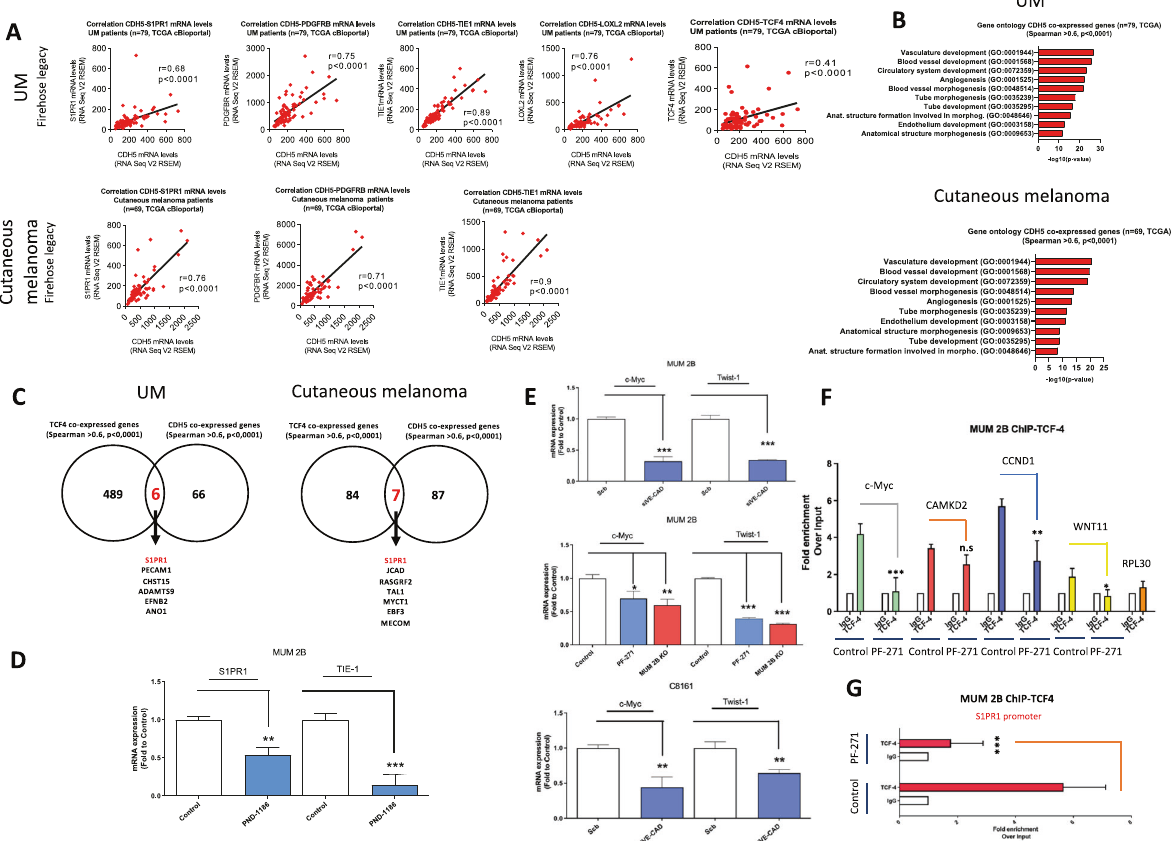
Fig. 4 VE-Cadherin/ β -catenin forms a complex in FAK-dependent manner enhance TCF-4 transcription activity. A Evaluation of the correlation between CDH5 and S1PR1, PDGFRB, TIE1, LOXL2, and TCF4 mRNA levels in a cohort of uveal melanoma ( n = 79, TCGA Firehose legacy) and cutaneous melanoma patients ( n = 69, TCGA, Firehose legacy) using cBioPortal. Correlation analysis was done using the Spearman test. B Top 10 gene ontology terms of CDH5 positive correlated genes ( r > 0.6, p < 0.0001) from previous cohorts. C Venn diagram comparing CDH5 and TCF4 positive correlated genes was done using the Spearman test ( r > 0.6, p < 0.0001). D , E qPCR experiments with FAK-inhibitors, silencing VE-Cadherin (50 nM during 48 h) in MUM 2B and C8161 cells or MUM 2B ko cells showed strong downregulation of